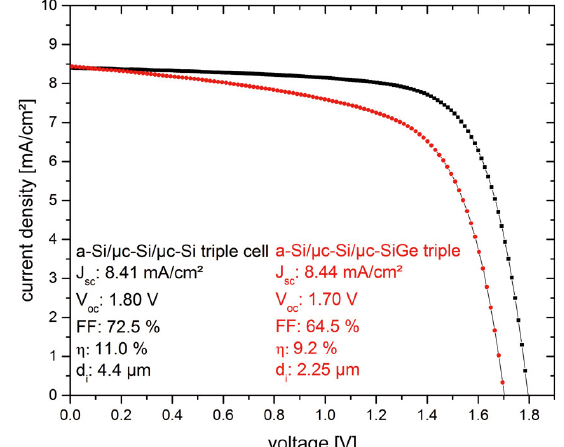
Fig. 6. Comparison of IV-curves of a triple-junction solar cellc in an a-Si:H/ µ c-Si:H/ µ c-Si:H and a-Si:H/ µ c-Si:H/ µ c-SiGe:H